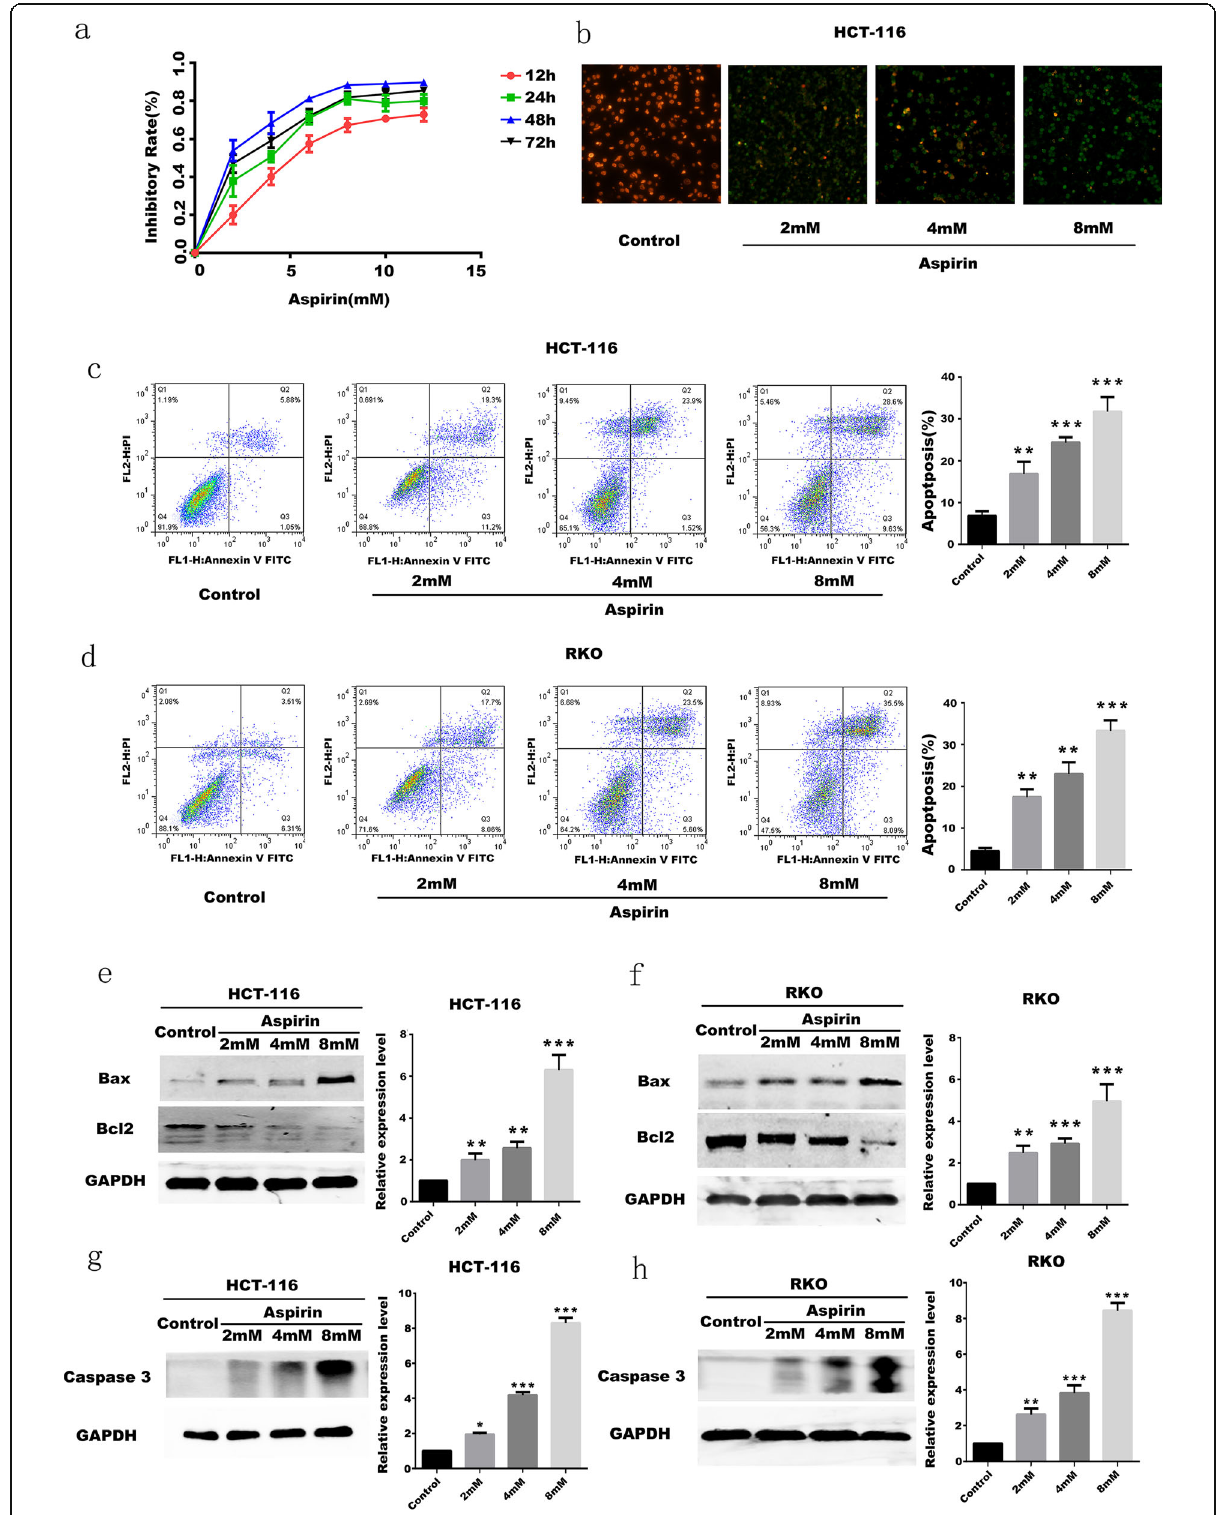
Fig. 3 (See legend on next